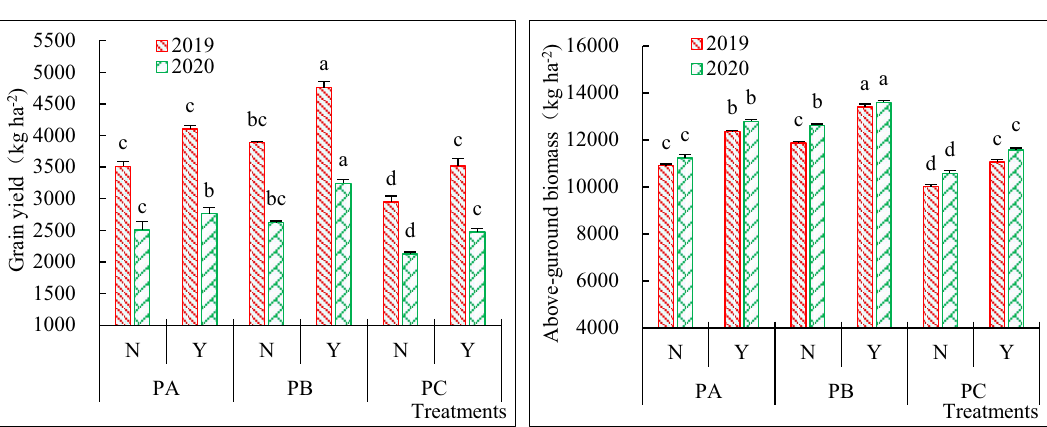
Figure 4. Grain yield and above-ground biomass of oat as affected by planting patterns and super absorbent polymers in 2019–2020. Notes Smaller bar represents the standard error of mean (n = 3); Different letters in the same year represent significant differences at 0.05